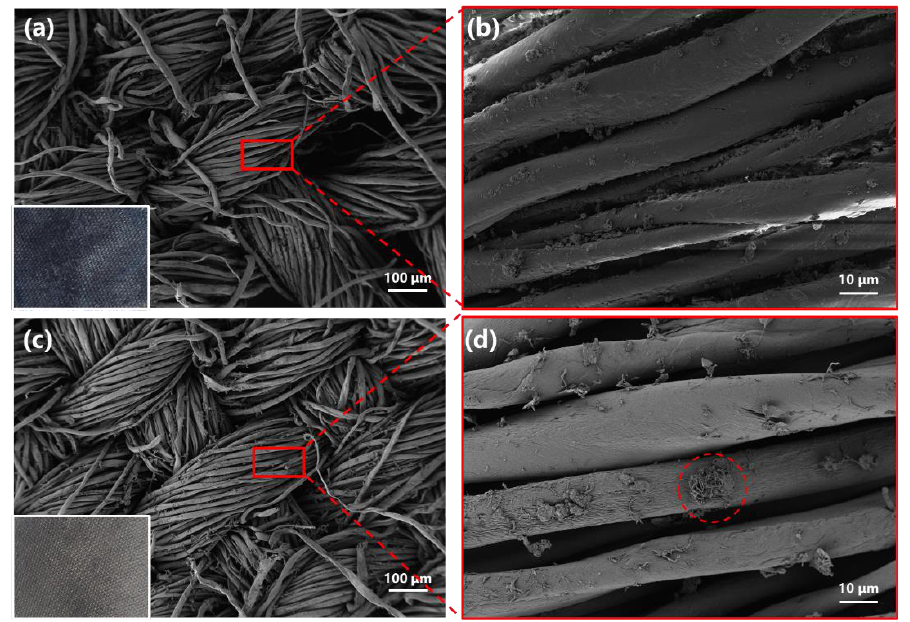
Figure 6. SEM images of functional cotton fabrics after ( a ) rubbing and ( c ) accelerated laundering; Enlarged partial SEM images of functional cotton fabrics after ( b ) rubbing and ( d ) accelerated laundering.